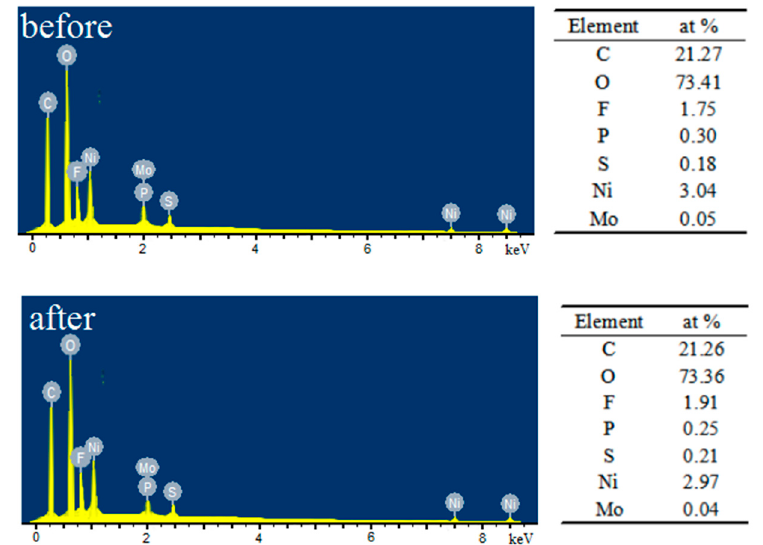
Figure 9. EDS spectra of the Ni–MP/MoS 2 composite before and after the stability test.